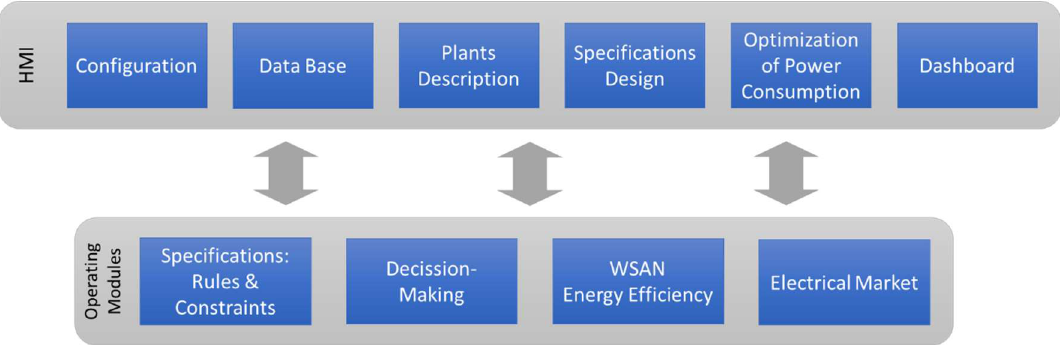
Figure 7. Software Architecture.